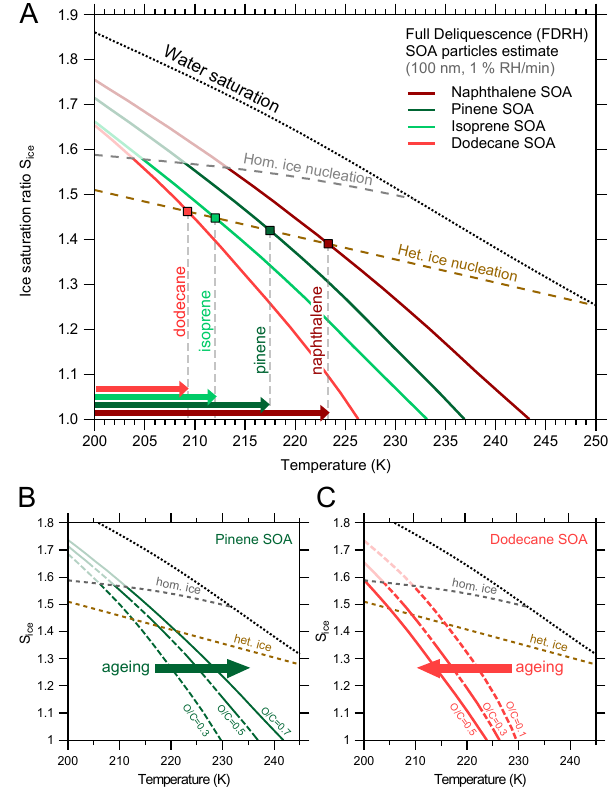
Figure 3. (a) Simulated humidification of SOA particles from the four different precursors α -pinene, isoprene, dodecane and naphtha- lene. Naphthalene SOA (dark red) shows the latest deliquescence, whereas dodecane SOA (light red) liquefied rather early in the simu- lations. The two biogenic SOA estimates lie between both extremes with pinene SOA (dark green) showing slightly later deliquescence than isoprene SOA. Intercepts (square markers) with a heteroge- neous nucleation onset typical of SOA (brown dashed line) indicate upper temperature limits for immersion freezing (arrows on x axis). The effect of particle ageing also depends on precursor type: pinene SOA (b) shows hardening upon increase in O / C (indicated by higher FDRH), whereas dodecane SOA (c) exhibits softening (in- dicated by lower FDRH). Similarly, isoprene and naphthalene SOA show only moderate hardening and softening, respectively (Fig.